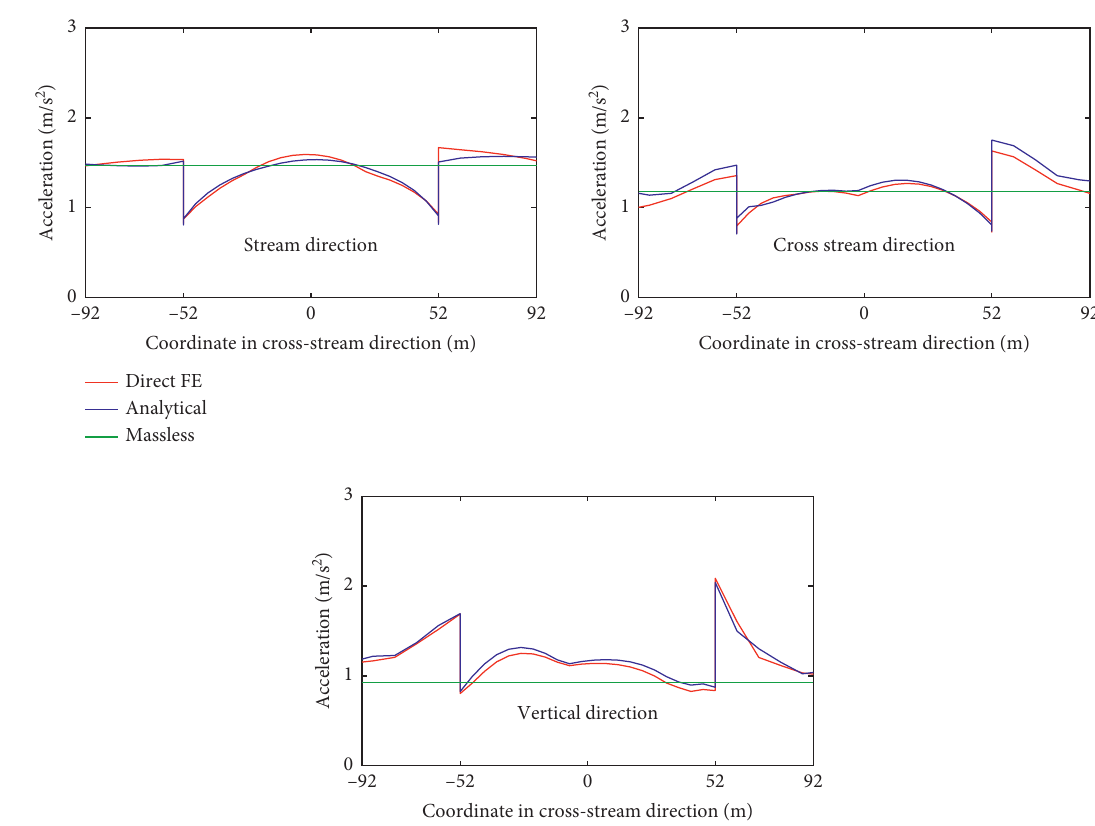
Figure 9: Distribution of PGA recorded at points along the canyon free surface induced by the Swedish design earthquake in the (a) stream, (b) cross-stream, and (c) vertical directions for free-field modelling of the rock foundation using the direct FE method, analytical method, and massless